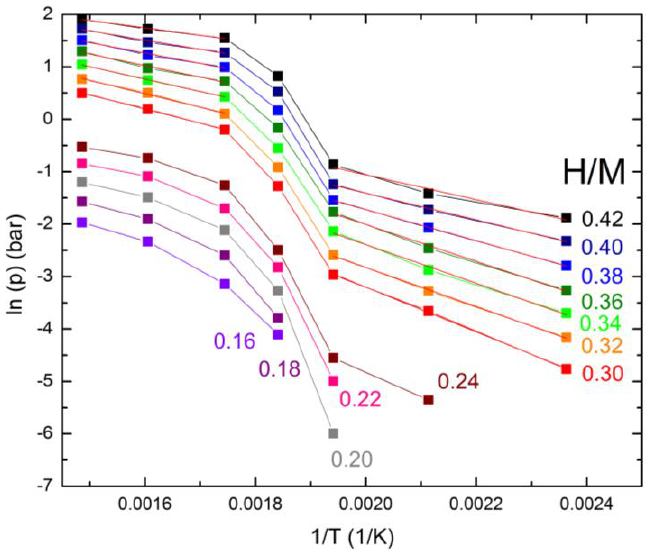
Figure 3. Van’t Hoff plot for the Ni 32 Nb 28 Zr 30 Cu 10 membrane calculated at different H/M ratios and best fit lines in the low- and high-temperature range.